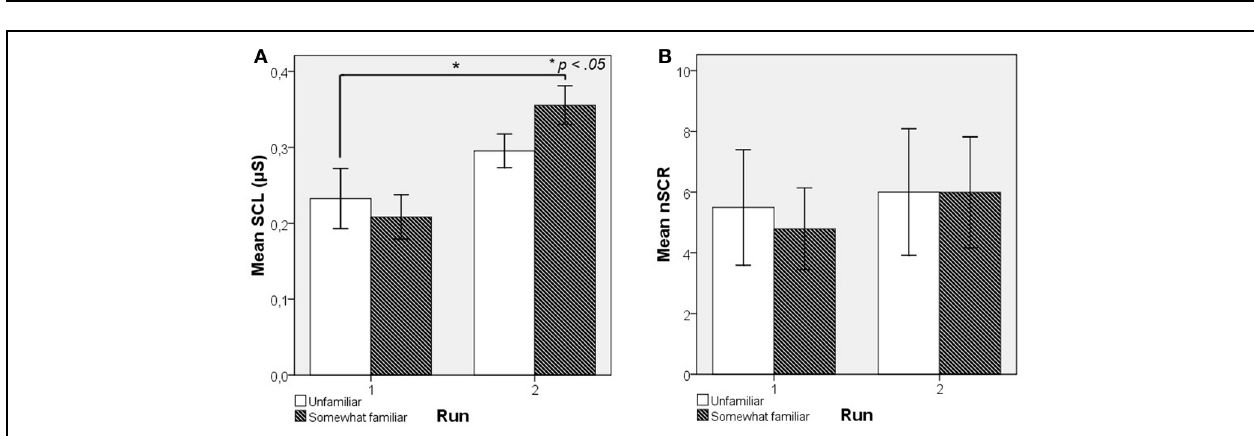
FIGURE 3 | Mean skin conductance level values as a function of exposure from Experiment 2. Exposure (run 1 vs. run 2) to the same musical pieces results in significantly higher mean SCL values (A) but not nSCR values (B) .